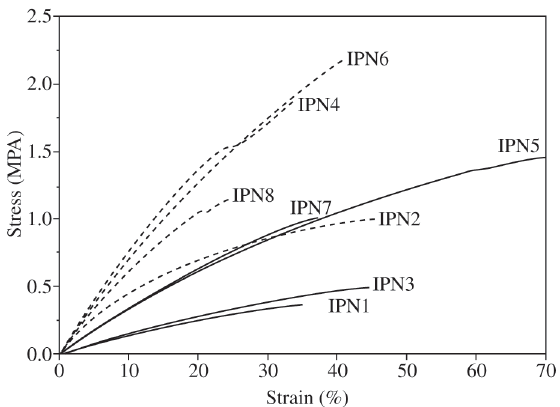
Figure 3. Stress-stain curves of semi-IPN cured as thermal treat- ment